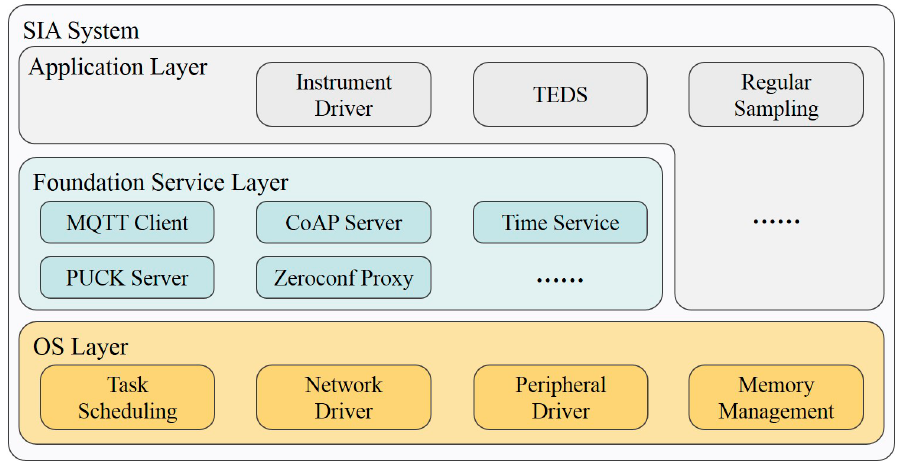
Figure 9. The software architecture of the SIA.